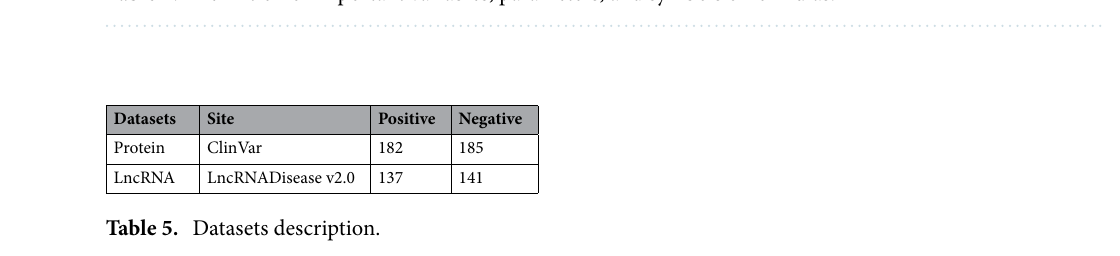
Table 4. Definition of important variables, parameters, and symbols of formulas.